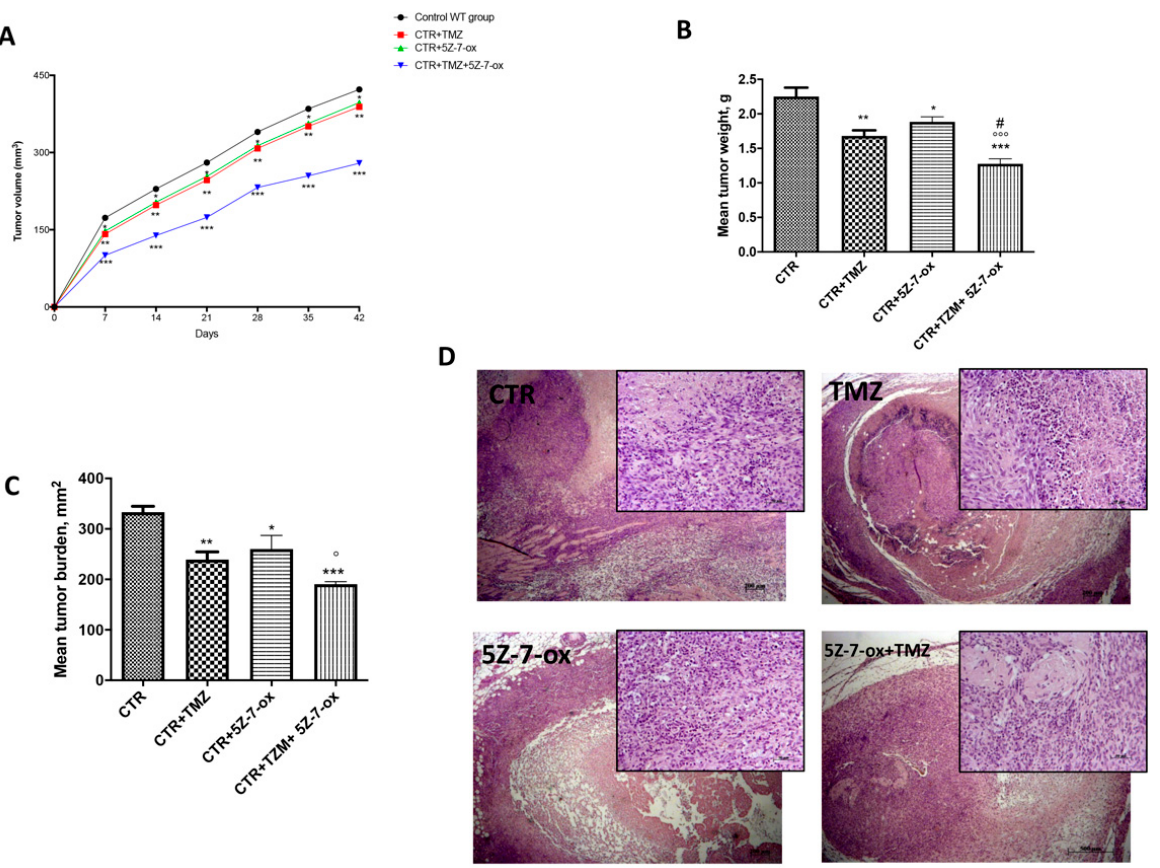
Figure 6. Effect of 5Z-7-Ox on tumor growth in the in vivo study. The panel ( A ) and ( B ) showed a significant reduction in tumor volume and weight, respectively. The panel ( C ) demonstrated that the association of 5Z-7-Ox and TMZ conferred a greater resistance to the tumor onset and expansion. As shown in panel ( D ), the association between TMZ and 5Z-7-Ox significantly reduced tumor sections as well as neutrophil infiltration, much more than single components. Data are representative of at least three independent experiments. ( A ) * p < 0.05 vs. CTR; ** p < 0.01 vs. CTR; *** p < 0.001 vs. CTR. ( B ) ** p < 0.01 vs. CTR; * p < 0.05 vs. CTR; *** p < 0.001 vs. CTR; ◦◦◦ p < 0.001 vs. CTR+5Z-7-Ox; # p < 0.05 vs. CTR+TMZ ( C ) ** p < 0.01 vs. CTR; * p < 0.05 vs. CTR; *** p <0.001 vs. CTR; ◦ p < 0.05 vs. CTR+5Z-7-Ox.